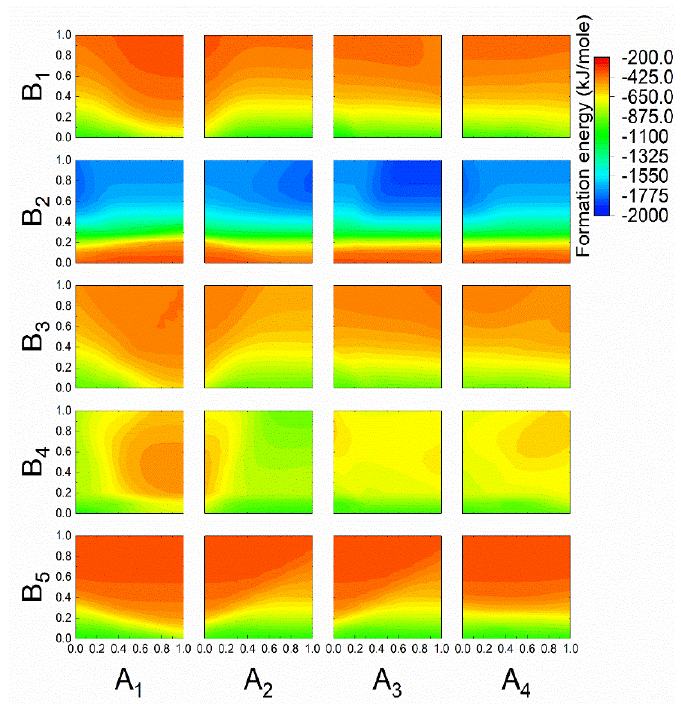
Figure 5. The predicted formation energies of the spinel-structured HEOx with different proportions of metal cations in the A and B sites.